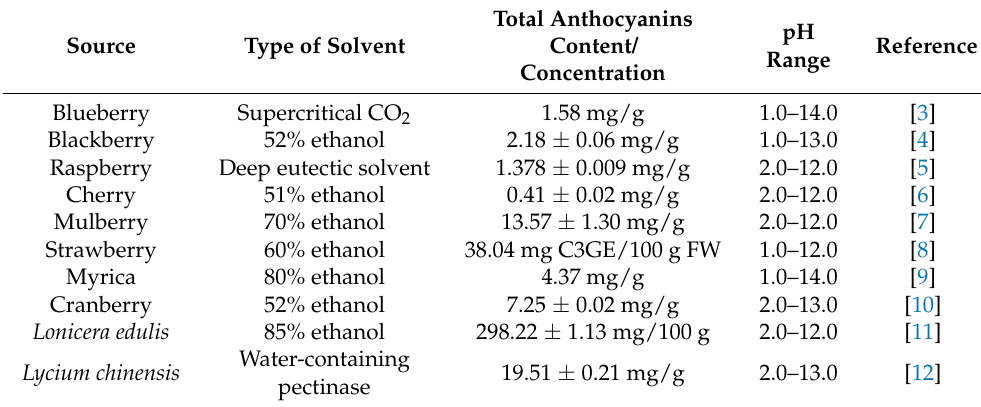
Table 1. Anthocyanins content and extraction solvents of different